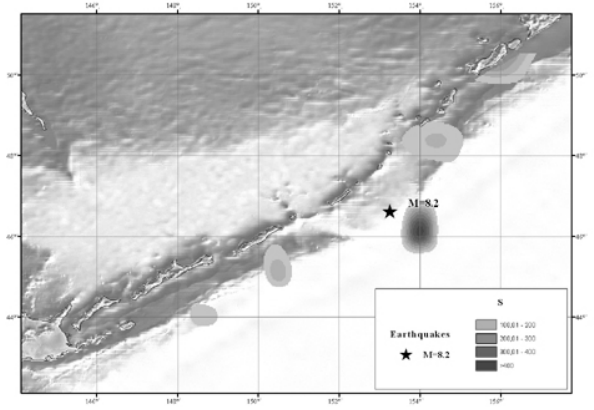
Fig. 7. Areas of foreshock activation before the Simushirskoe earthquake. The star marks the main shock M = 8 . 2.